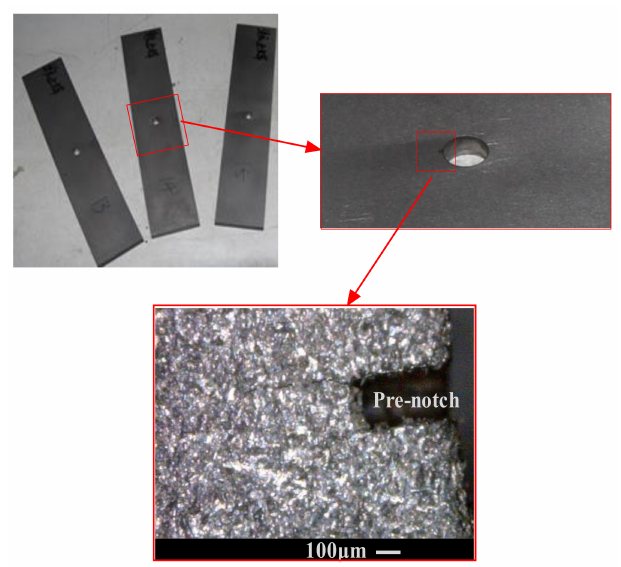
Figure 1. The prenotch shape and location.